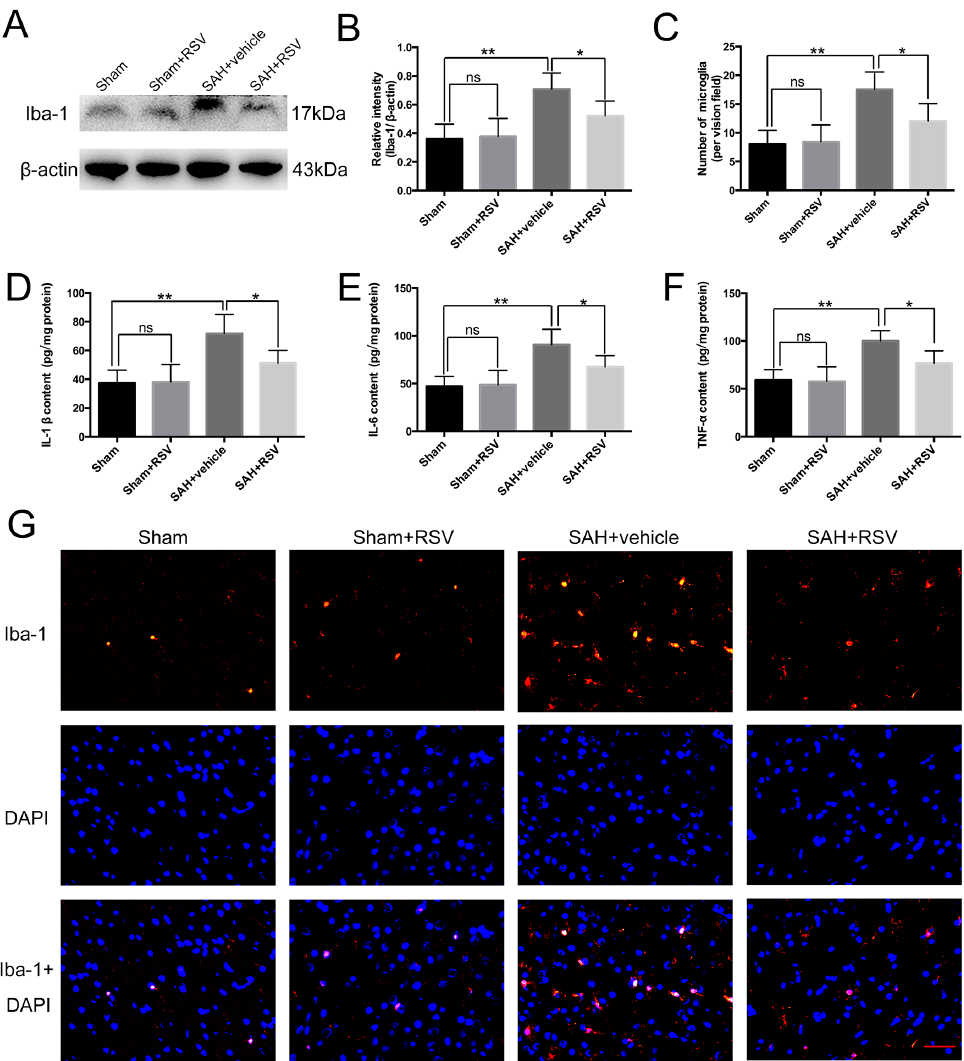
Figure 1. Effects of resveratrol (RSV) treatment on pro-inflammatory cytokine release and microglia activation at 24 h post subarachnoid hemorrhage (SAH). ( A , B ) Western blot analysis showing that RSV administration significantly suppressed Iba-1 (microglia marker) expression after SAH; ( C , G ) Immunofluorescence staining indicted that RSV could evidently reduce the number of activated microglia; ( D – F ) RSV markedly alleviated the expression of IL-1 β , IL-6, and TNF- α in the brain cortex after SAH. Bars represent the mean ± SD. ** p < 0.01, * p < 0.05, and ns means non-significant. Scale Bars = 50 μ m.